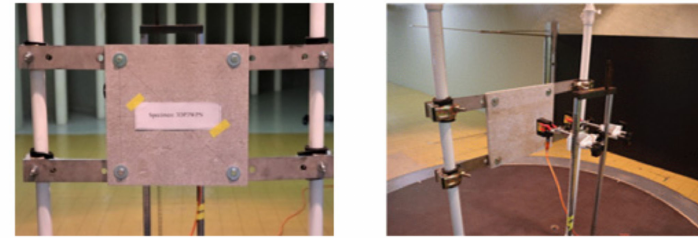
Figure 14. Installation of the test